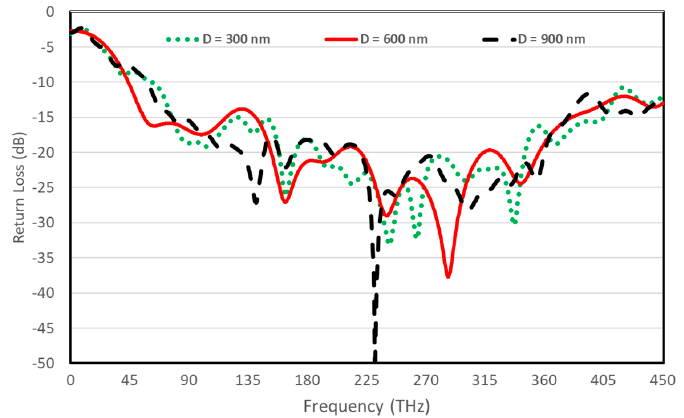
Figure 14. Performance comparison for various spacings between the elements in the 2 × 1 array design.